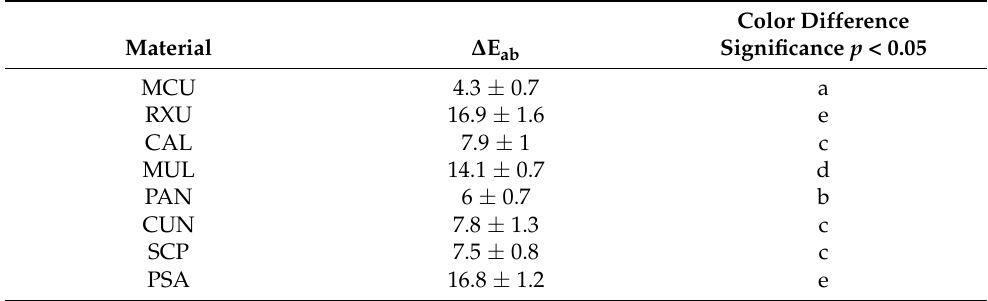
Table 2. Descriptive statistics of the recorded color differences values in ∆ E ab (mean ± stan- dard deviation); in the significance column different letters label statistically significant between- group